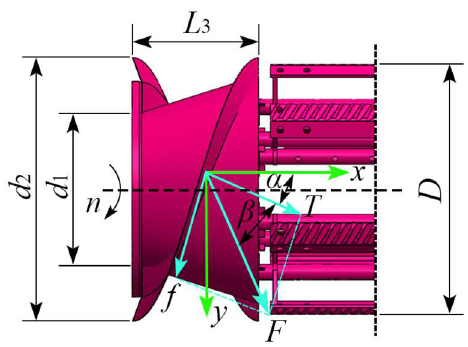
Figure 5. Force analysis of screw feed head and flax stem: Note: f is the frictional force between the flax plant and the spiral blade, N; T is the normal thrust, N; F is the combined frictional and thrust force, N; ω is the angular speed of the threshing drum in rad·s −1 ; D is the diameter of the threshing drum in mm; d 1 is the diameter of the small end of the spiral feeding head in mm; d 2 is the diameter of the large end of the spiral feeding head in mm; L 3 is the length of the spiral feeding head in mm; β is the angle of friction between the threshing material and the spiral blade, (°); α is the angle of lift of the spiral blade, (°).